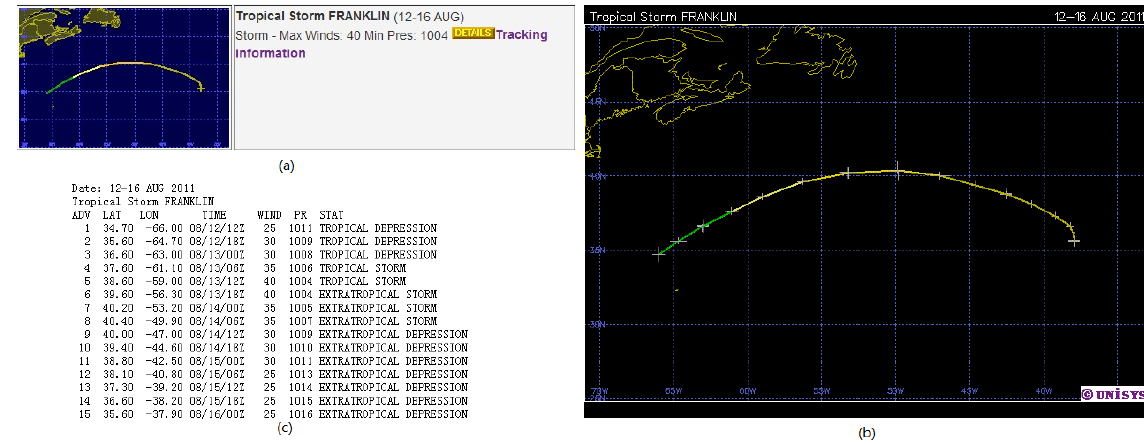
Fig. 2. A certain hurricane. (a) the summary information; (b) the schematic diagram of its trajectory; (c) the trajectory